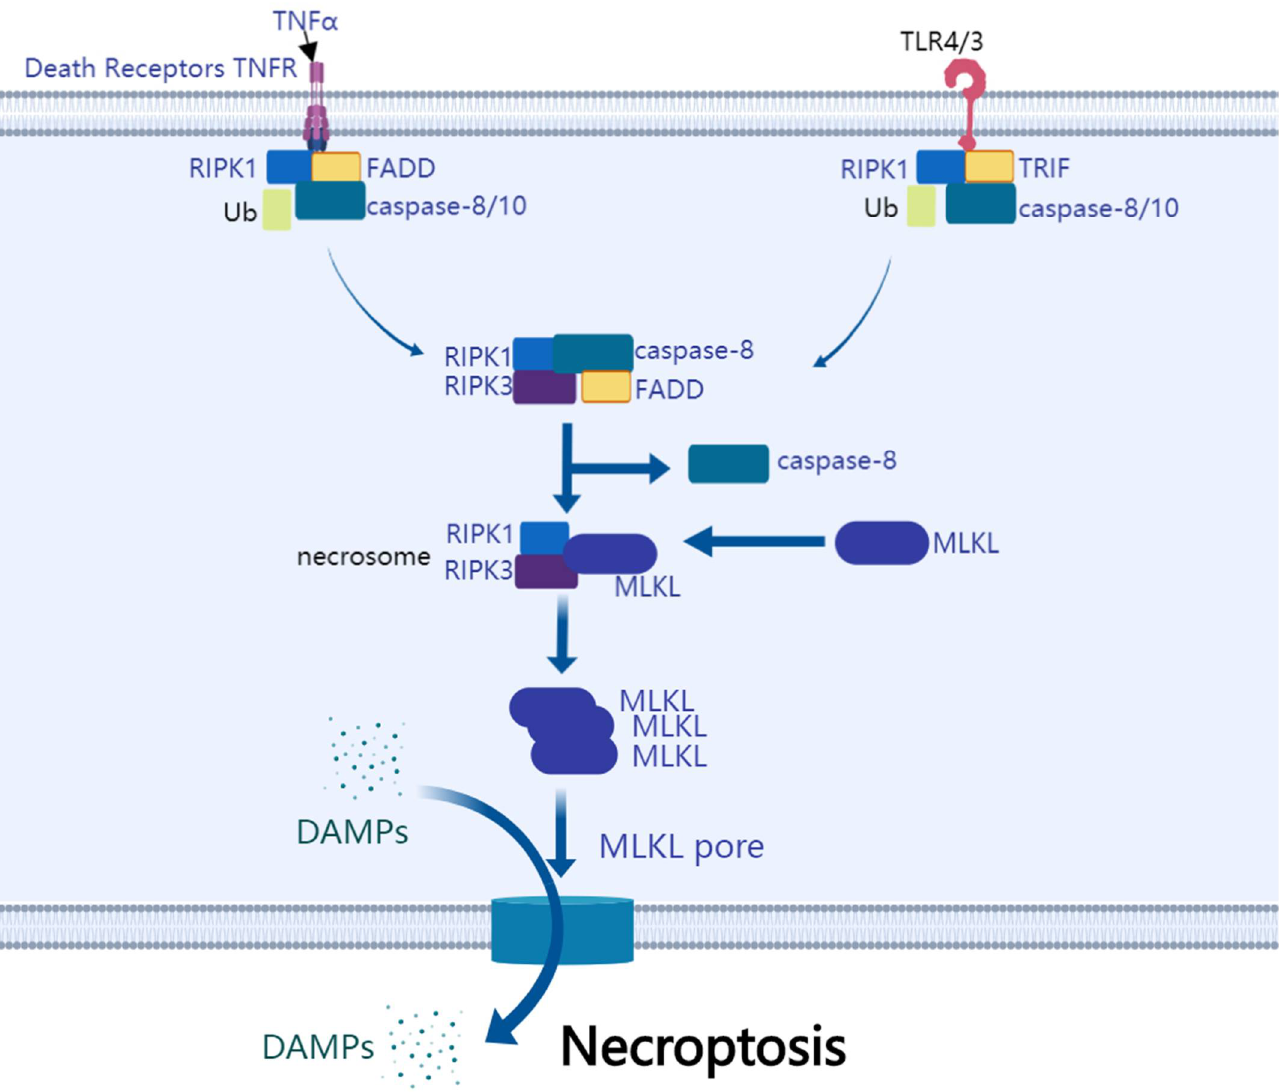
Figure 4. Schematic diagram of necroptosis